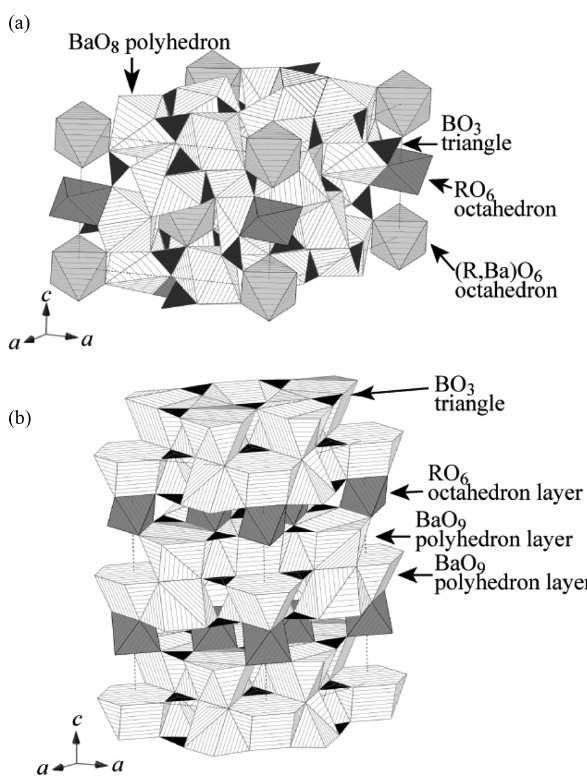
Figure 1: Schematic illustration of the crystal structures of the (a) H phase and (b) L phase. Oxygen-coordinated polyhedrons of cations ( R = REE), Ba, and B) are drawn. The H phase is constructed of BO 3 triangles, BaO 8 polyhedrons, (Ba, R )O 6 octahedrons, and R O 6 octa- hedrons. The L phase is composed of three types of alternating layers; BO 3 triangles, BaO 9 polyhedrons, and R O 6 octahedrons.